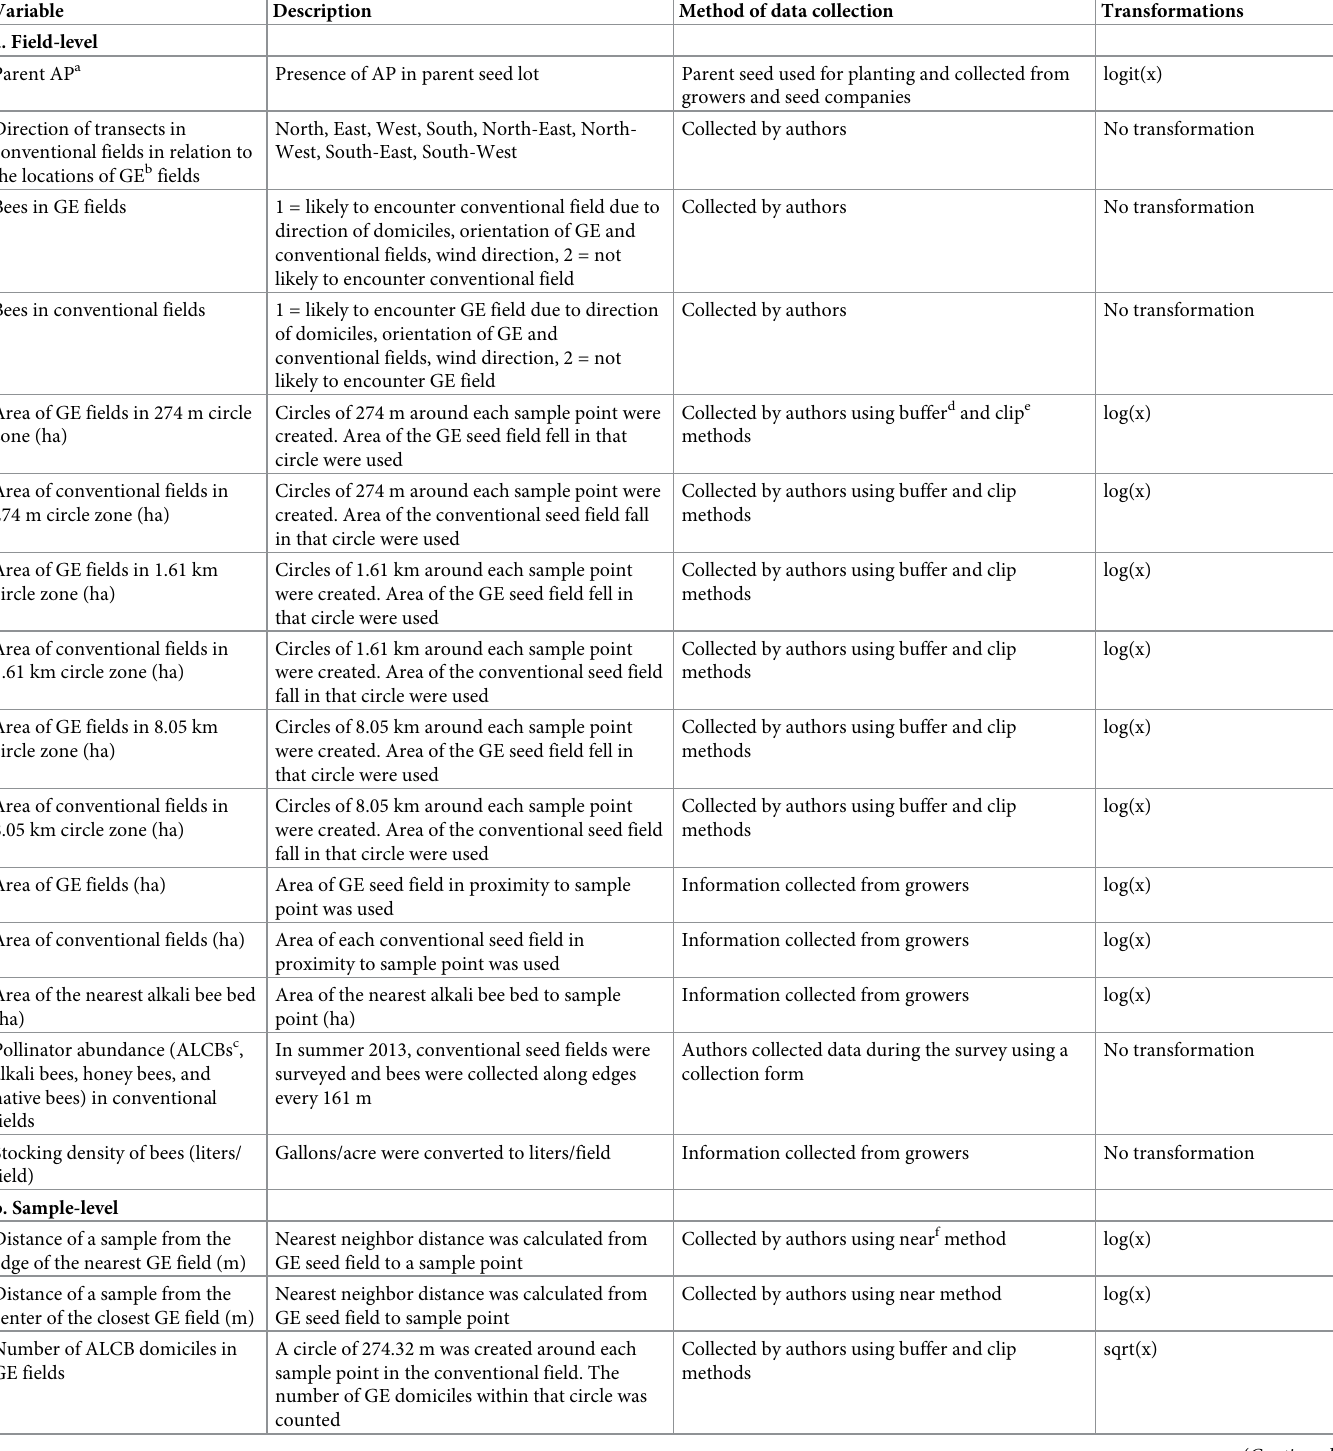
Table 1. Explanatory variables used in the models to explain gene flow from commercial genetically engineered fields to conventional fields. The variables fell into two categories: a. Field-level and b. Sample-level variables. Field-level variables were characteristic of a field, and had a single value per field. Sample-level variables were measured multiple times within a given field and were characteristic of a given seed sample location within a